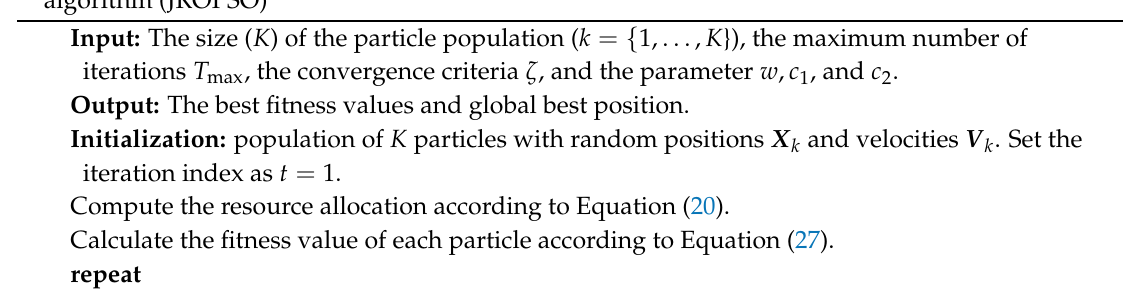
Algorithm 2: PSO-based joint resource allocation and computational offloading decision algorithm